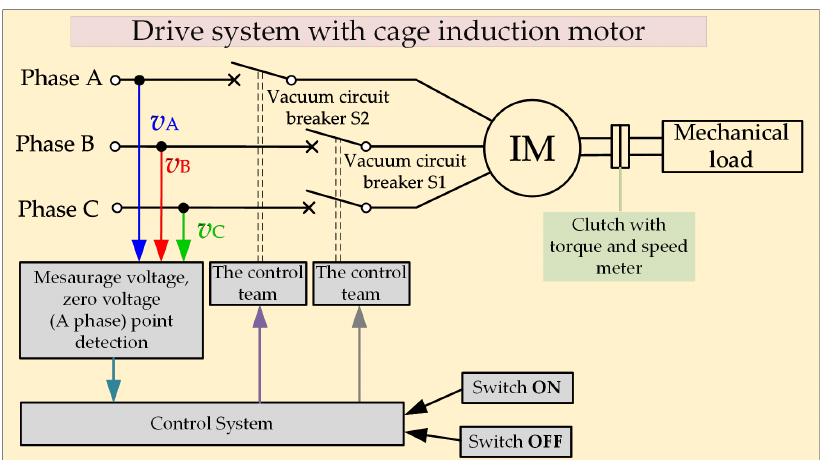
Figure 15. Detailed schematic diagram of the analyzed electromechanical system with cage induction